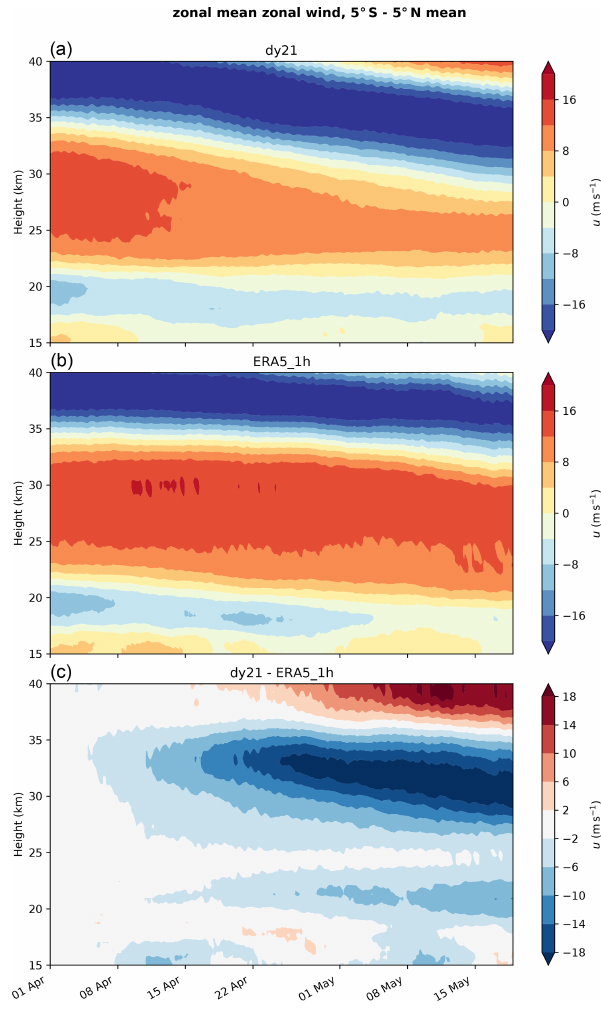
Figure 9. Zonal mean zonal wind u averaged from 5 ◦ S to 5 ◦ N from 1 January to 20 May 2004 in the simulation dy21 (a) and ERA5 (b) and the difference between dy21 and